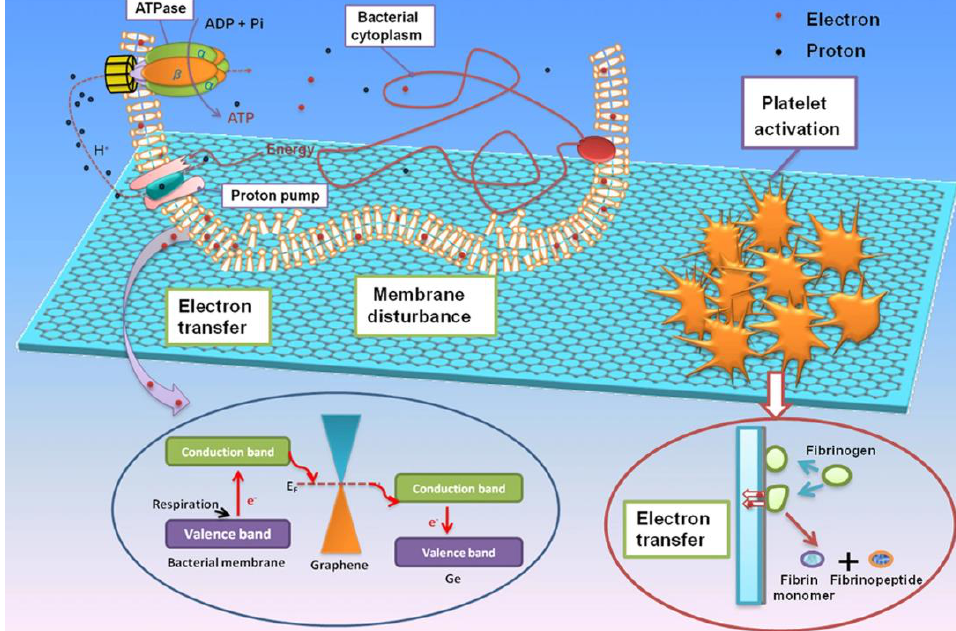
Figure 4. Schematic diagram of the interaction between bacteria (platelets) and graphene films covered with graphene substrates. (Printed image with permission from Ref. [84], copyright 2016, Nature Publication).